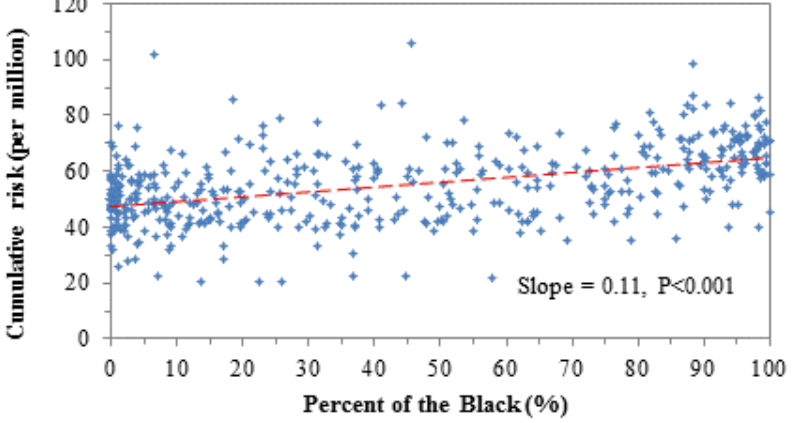
Figure A3. Relationship between the cumulative risk from all toxics and percent of the population that is